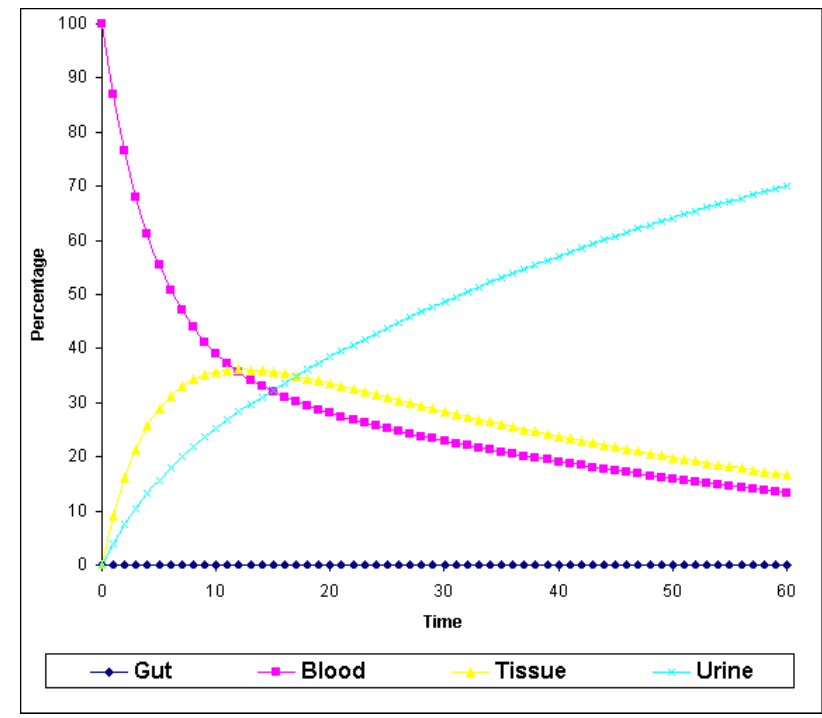
FIGURE 4 . Typical simulation of distribution into tissues, and elimination into urine of an intravenously dosed drug.